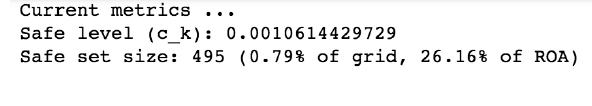
Figure 7: Initial safe level and safe set size for AS equilib- rium with maximum state variables and control input defined in (19).